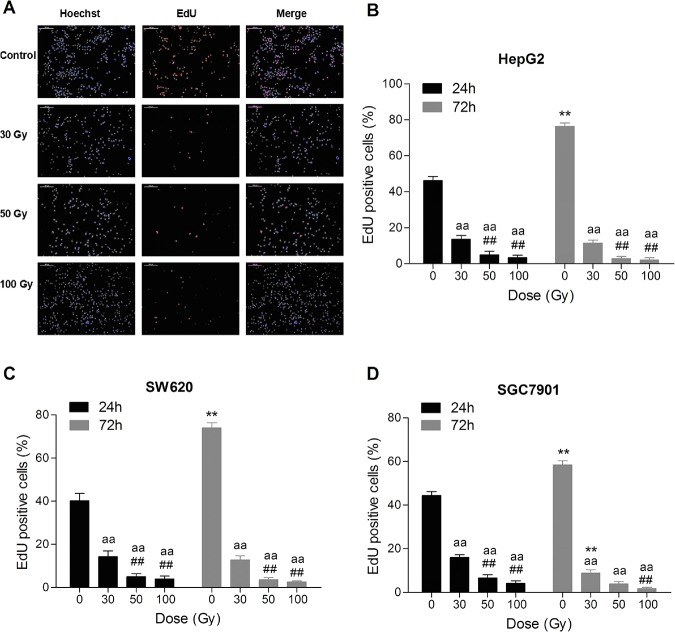

137Cs gamma-ray irradiation inhibits DNA synthesis in tumor cell lines in vitro.After 137Cs gamma-ray irradiation (0, 30, 50 and 100 Gy), HepG2, SW620 and SGC7901 cells separated from human erythrocytes were cultured for 24 h, and then DNA synthesis was detected by 5-ethynyl-2'-deoxyuridine (EdU) incorporation. Representative DNA synthesis (scale bar: 200 μm) of HepG2 cells at 24 h after irradiation with 0, 30, 50 and 100 Gy (A). DNA synthesis in HepG2 (B), SW620 (C) and SGC7901 (D) cells at 24 h and 72 h after irradiation. Date are means ± SEM; n = 6 erythrocyte samples from 6 volunteers in each group. **P<0.01 vs. the same treated group culturing for 24 h; ##
P<0.01 vs. 30 Gy irradiation group at the same culture time; aa
P<0.01 vs. Con (the dose of irradiation was 0 Gy) at the same incubation time after treatment.